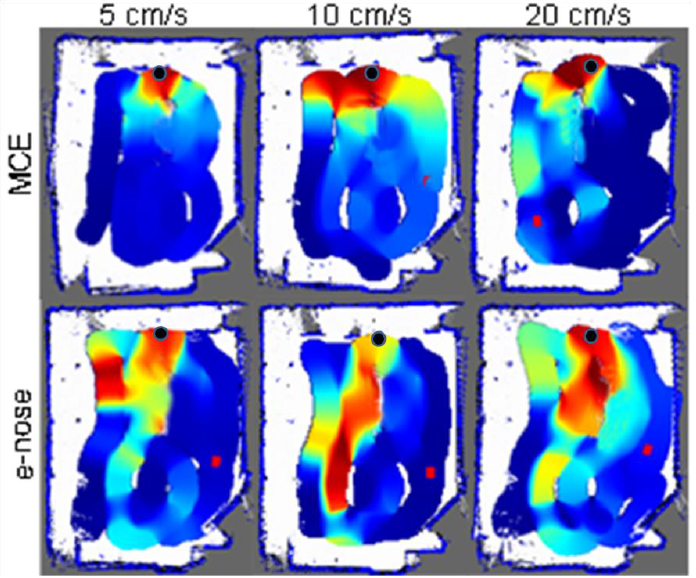
Figure 17. A comparison of the gas concentration maps produced by a conventional e-nose and the MCE-nose for three different robot